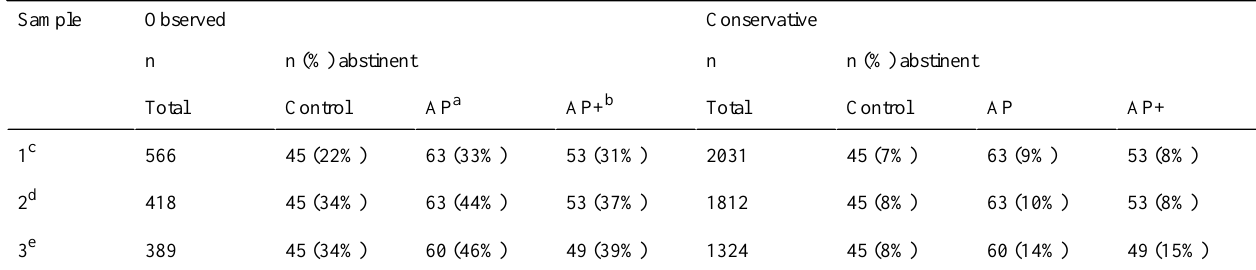
Table 2. 12-month abstinence rates per program for the three samples using observed and conservative analyses.